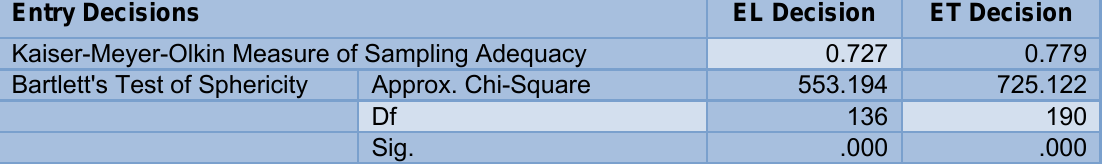
Table 1: KMO Measure of Sampling Adequacy and Bartlett’s Test of Sphericity for EL and ET Decisions Entry